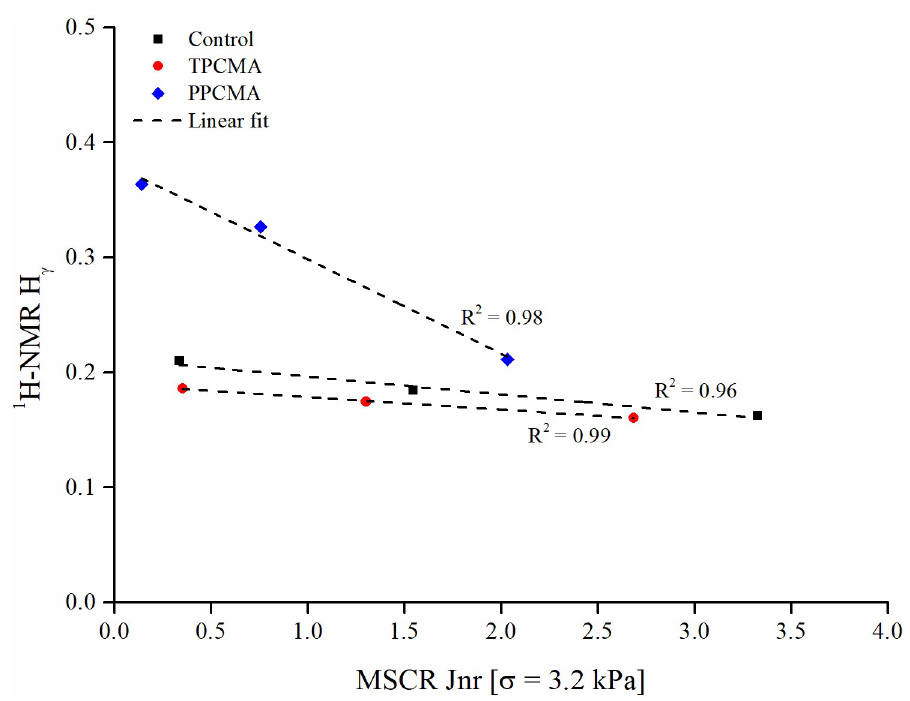
Fig 18. Correlation between MSCR J